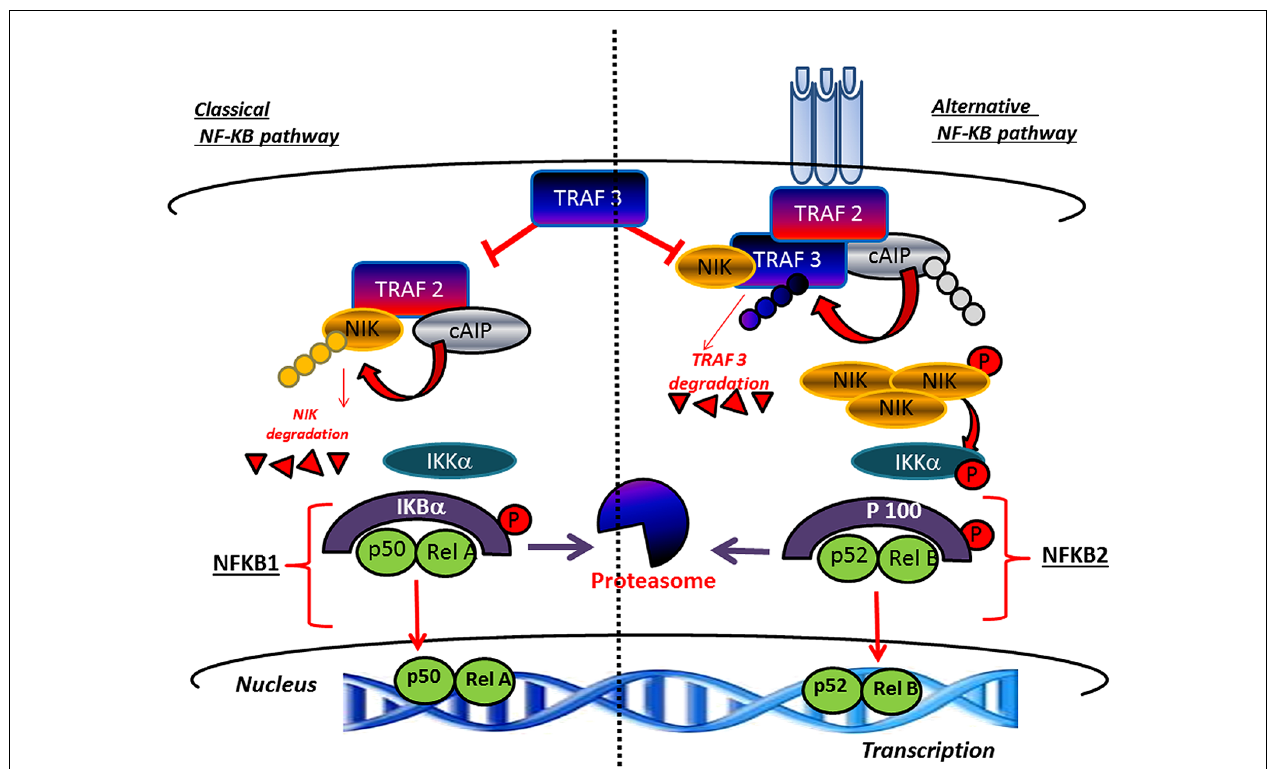
FIGURE 3 | Canonical and non-canonical pathway leading to the activation of NF- κ B. TRAF3 inhibits activation of the classical NF κ B pathway A high level of TRAF3 interferes with the recruitment of TRAF2 to the receptor. In parallel, TRAF3 induces NIK degradation and consequently inhibits the activation of the alternative arm of NF κ B. The activation of canonical pathway results in the phosphorylation of I κ B αα by the IKK complex, leading to its ubiquitylation and subsequent degradation by the proteasome. The RelA/p50 complex is free to translocate to the